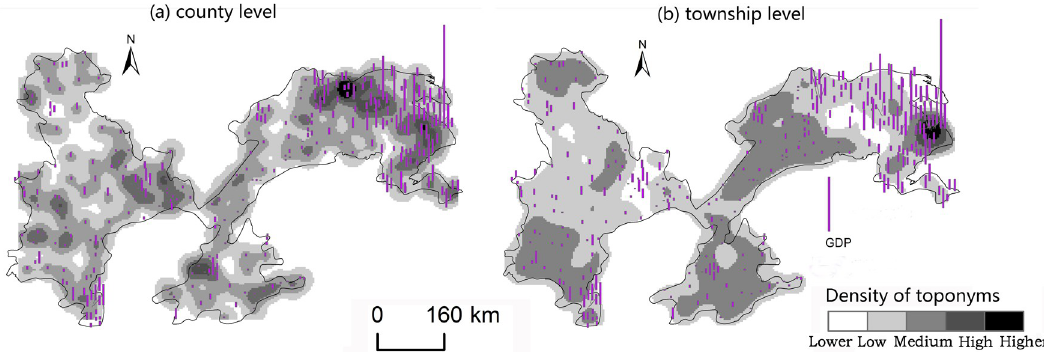
Fig 13. Spatial distribution of toponym density and county GDP of the Yangtze